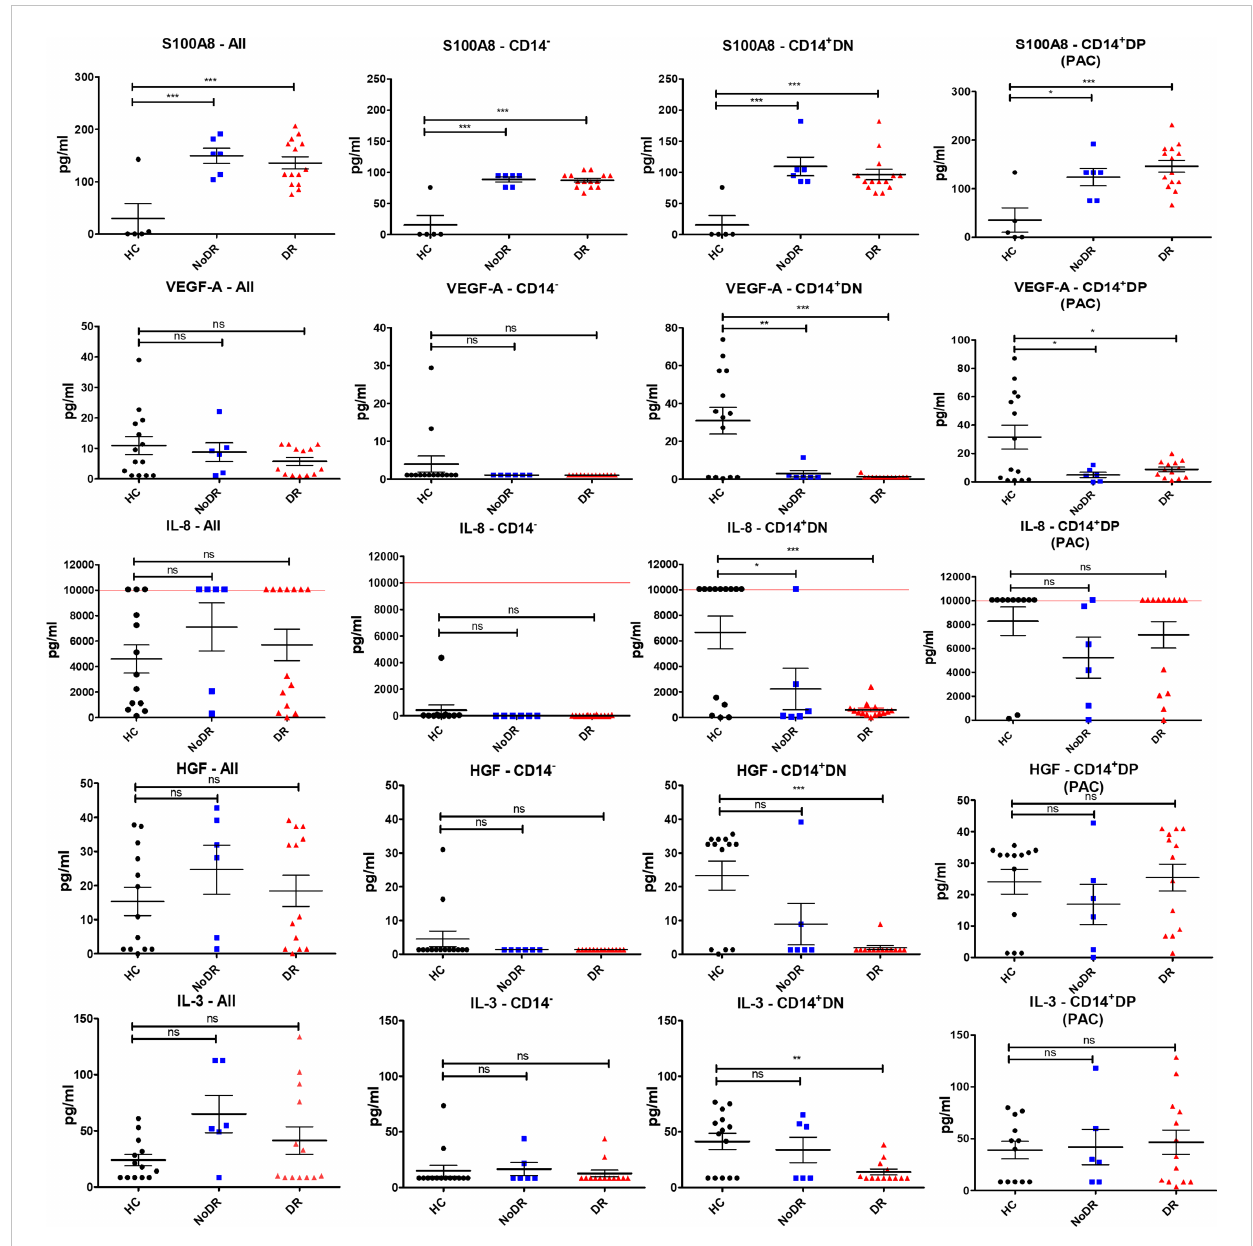
FIGURE 3 Myeloid-derived cells from patients with DR display the greatest imbalance in pro-angiogenic cytokine production compared to HC. PBMC isolated from HC (n = 14), NoDR (n = 6), and DR patients (n = 14) were cultured to differentiate into PAC. Four populations were isolated by fl ow cytometry: total live cells (All), lymphoid CD14 – CD105 – CD133 – (CD14 – ), and myeloid CD14 + CD105 – CD133 – (CD14 + DN), and CD14 + CD105 + CD133 + (CD14 + DP, PAC) cells. From each population 10E5 cells were cultured for 24 hours and conditioned media were tested for cytokine production using a multiplex assay. The experiments were performed in two technical replicates for each patient. Values above/below the limit of detection are assigned at the highest/lowest limit of detection of the kit. Error bars represent means ± standard error of the mean (SEM). Signi fi cance was calculated compared to the control using one-way ANOVA followed by post-hoc Tukey multiple comparison test. ns, non-signi fi cant, *p < 0.05, **p < 0.01, ***p <